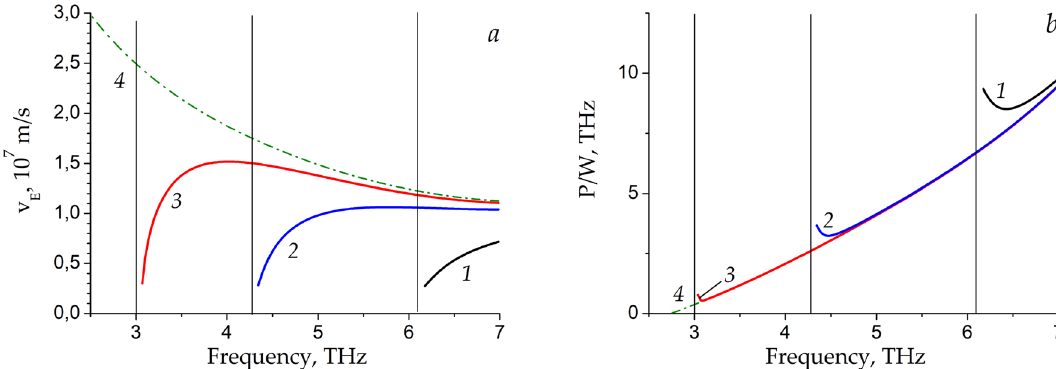
W between the power density released from Figure 5. The plasmon energy velocity ( a ) and the ratio P active graphene and plasmon energy density ( b ) in dependence on frequency for three different groove widths (cid:31) W L = 0.5 μm, 1 μm, and 2 μm indicated by curves 1 , 2 , and 3 , respectively. The energy velocity and the ratio P for the TM plasmon mode in the infinite graphene sheet with a metal screen are shown in panels a and b by (cid:31) dash-dotted curves 4 . Vertical straight thin lines indicate the cut-off frequencies of the LSM near the cut-off frequency. At low THz frequencies, the power increment of the LSM plasmon can exceed that of the TM plasmon by several times at the same frequency.